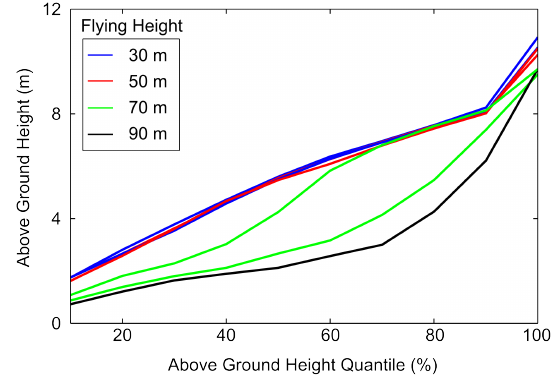
Figure 5. Above ground height quantiles measured from various flying heights for a single plot.